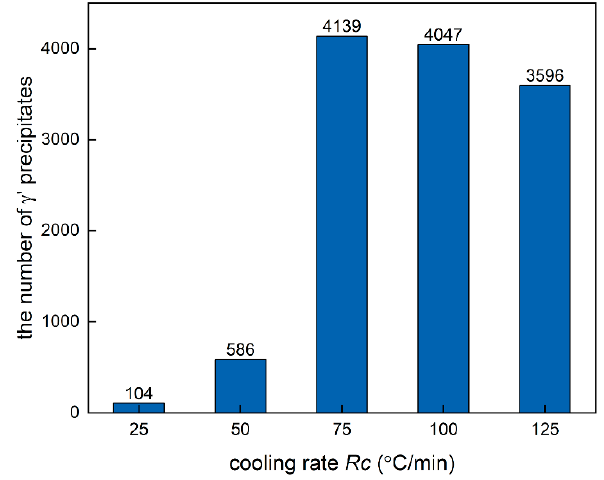
(cid:48) precipitates in DD6 at di ff erent cooling Figure 10. The number of γ  precipitates in DD6 at different cooling rates. Figure 10. The number of γ